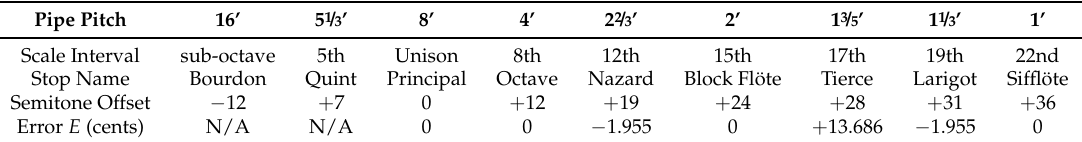
Table 1. Hammond Organ Drawbars—Pitch in organ stop lengths and musical